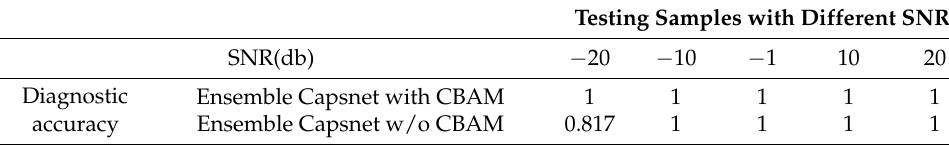
Table 3. The diagnostic accuracy of two diagnostic models on different SNR